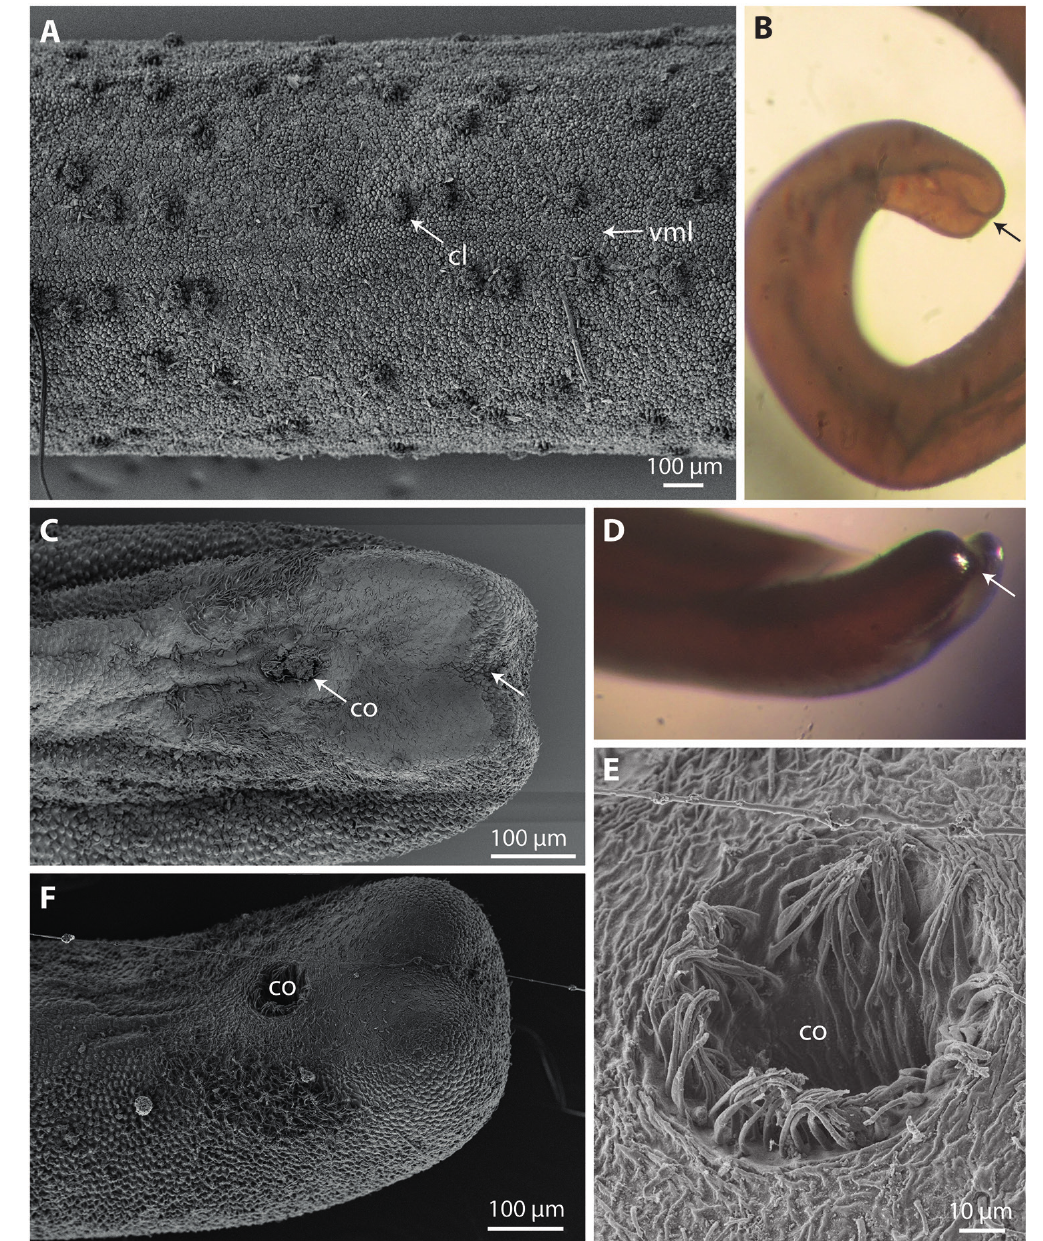
Figure 2. Chordodes colchis , male. A. Cuticle of the ventral side (vml = ventral midline) with the clusters of crowned areoles (cl). B–D, F. Posterior end with median longitudinal furrow (arrows in B–D) different degrees of partially divided posterior end. E. Cloacal opening (co) surrounded by branched circumcloacal bristles. A,C,E,F by SEM, B and D taken with Nicon Coolpix P